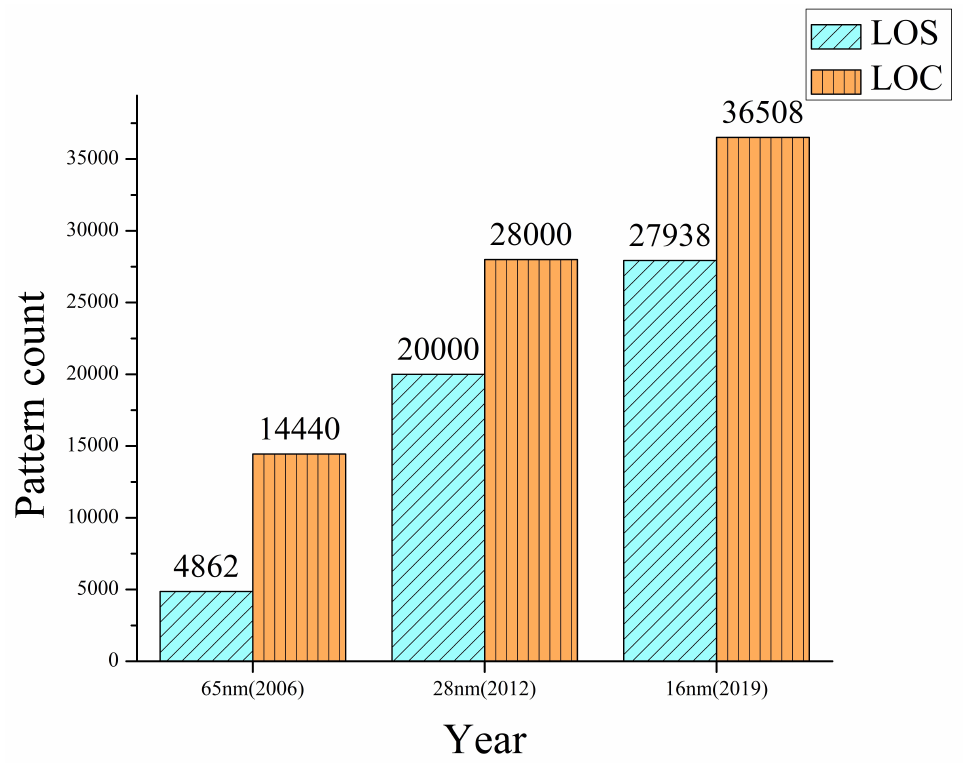
Figure 4. Comparison of LOS and LOC based pattern count (commercial ATPG tool) with the evolution of years